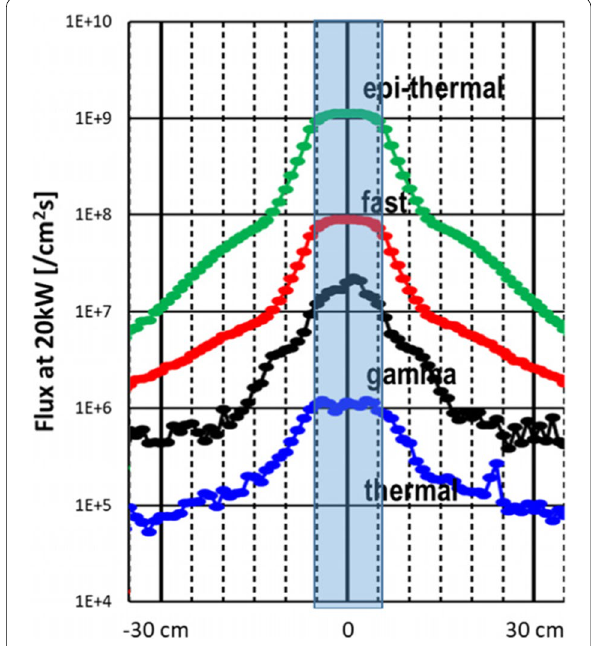
Fig. 17 Lateral flux beam profile at the BSA port. The shaded region indicates the width of the BSA port